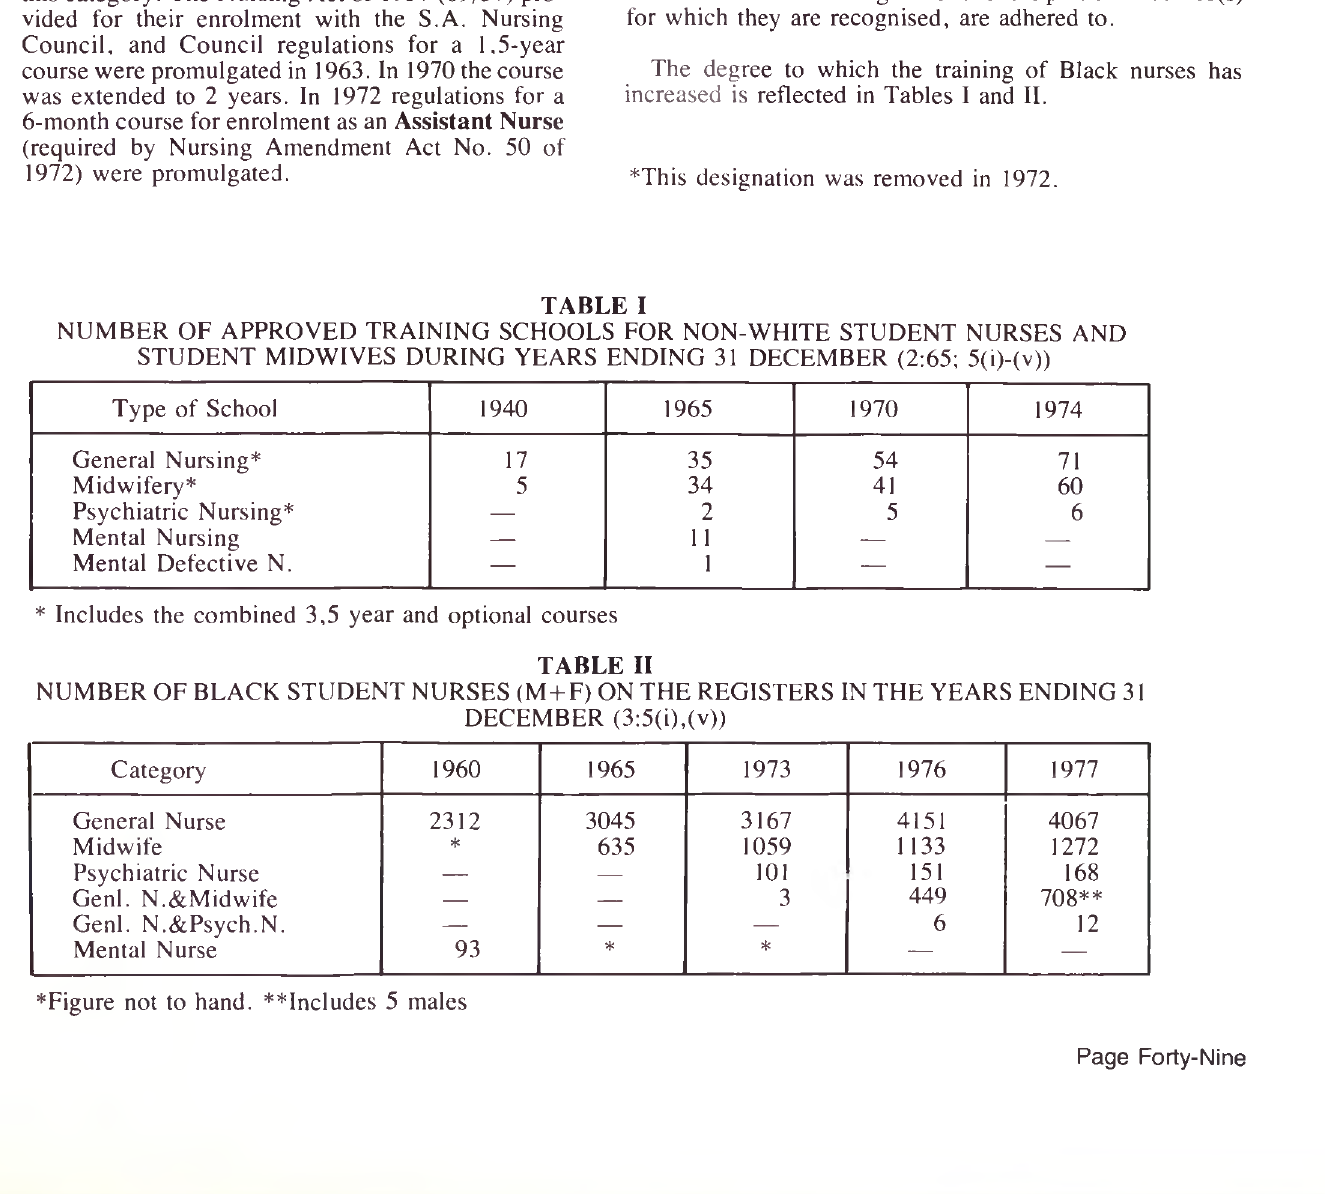
NUMBER OF APPROVED TRAINING SCHOOLS FOR NON-WHITE STUDENT NURSES AND